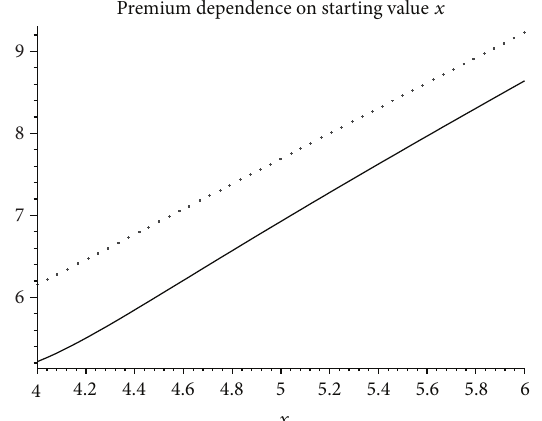
Figure 4: Premium as a function of the initial stock value. Equation (45) is the thick line while (12) is the thin, dotted one. Parameters are chosen as 𝑟 = 4.5 % yr −1 , 𝜎 = 30 %,